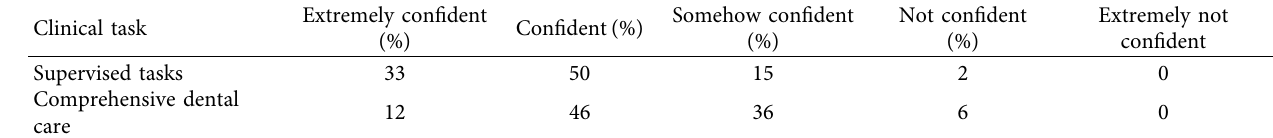
Table 1: Students self-perceived confidence level in different clinical settings.